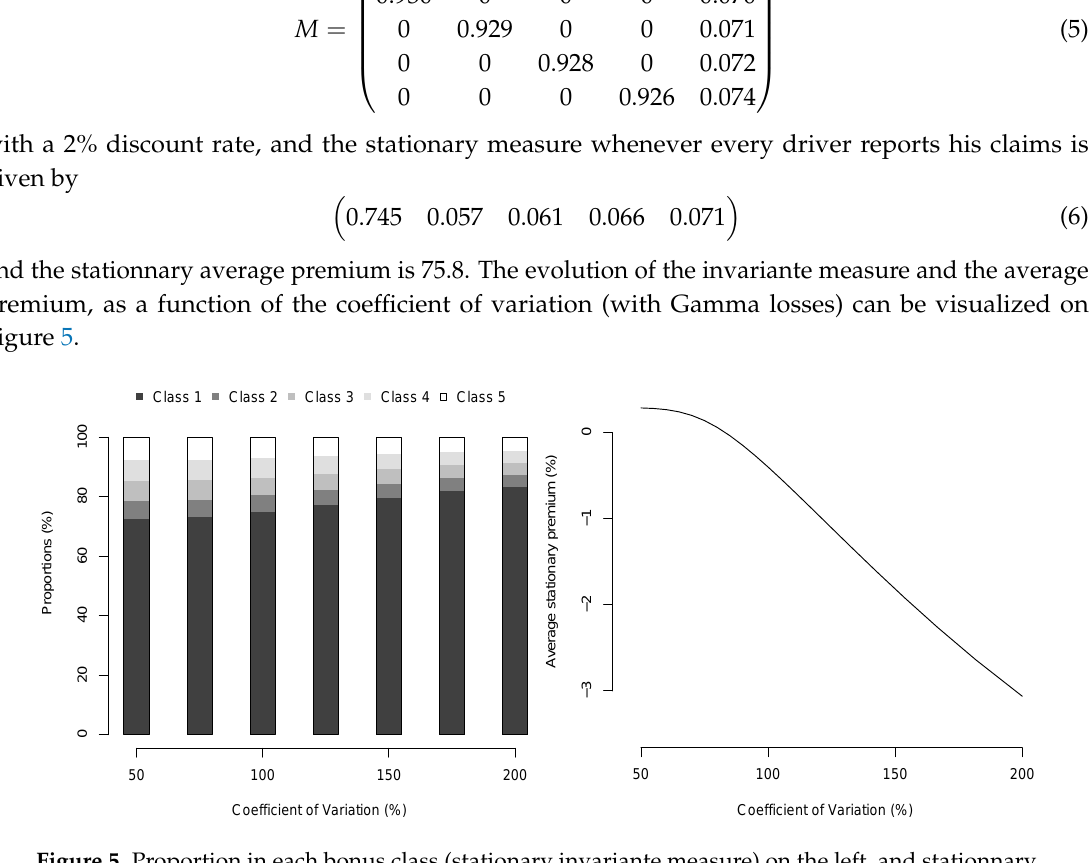
Figure 5. Proportion in each bonus class (stationary invariante measure) on the left, and stationnary average premium (as a percentage of the classical case where all claims are reported), as a function of losses coefficient of variation (with a Gamma